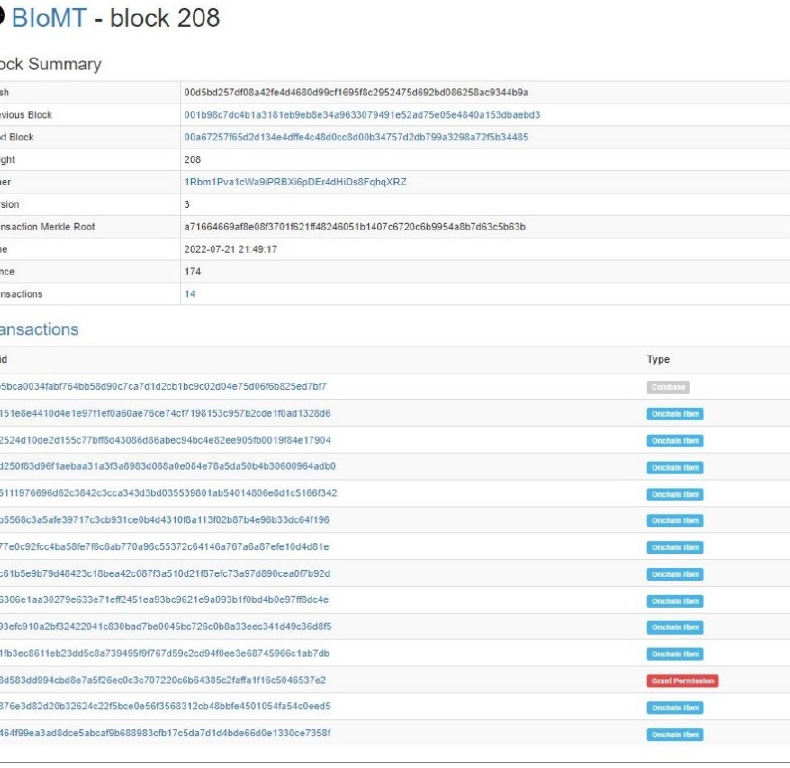
Figure 6. The content of one selected block from the implemented blockchain.